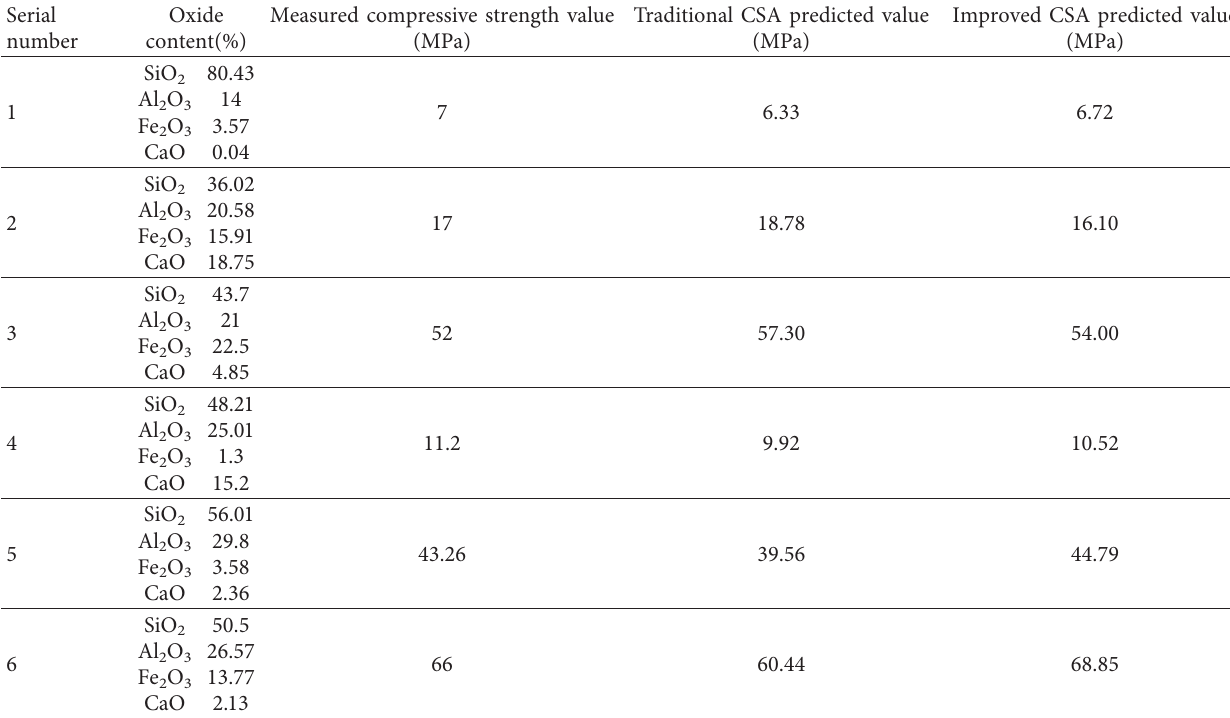
Table 6: Comparison of 7d compressive strength for different oxide proportions.